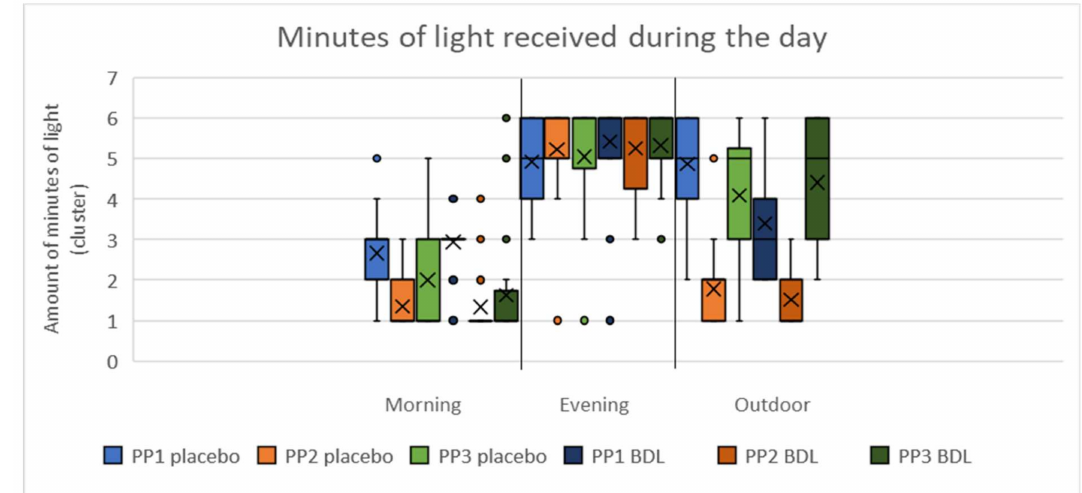
Figure 5. Boxplots of minutes of light received in the morning, evening and outdoor. The median is demonstrated as the ‘X’ within the boxplot. The length of the boxplot represents the interquartile range, and the boxplot whiskers are 1.5 times the interquartile range. All data points outside the whiskers are considered outliers. (Cluster 1 = 0–30 min light per day; cluster 2 = 30–60 min light per day; cluster 3 = 60–90 min light per day; cluster 4 = 90–120 min light per day; cluster 5 = 120–150 min light per day; cluster 6 ≥ 150 min light per day). Randomisation tests showed no significant difference between morning, evening and outside ( p >